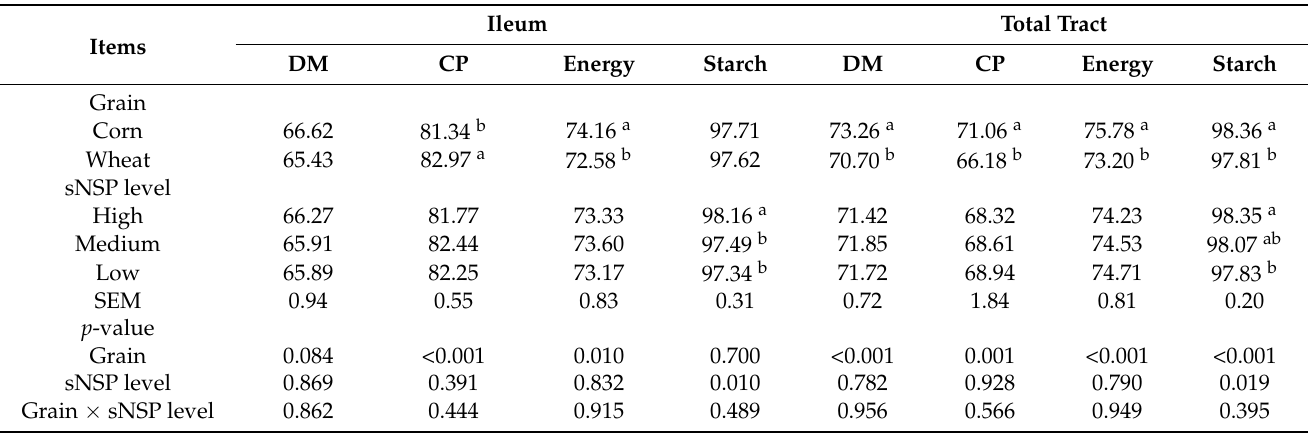
Table 7. Effect of dietary soluble non-starch polysaccharide (sNSP) level and grain source on